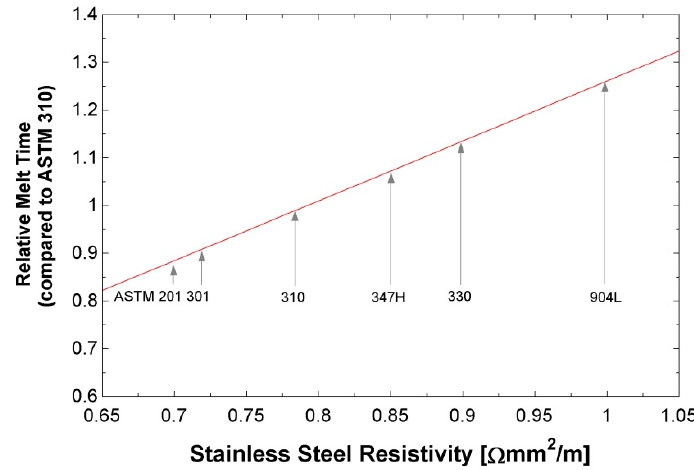
Figure 14. Relative melting times for different types of stainless steel based on resistivity. Table 6. Operation target metrics.